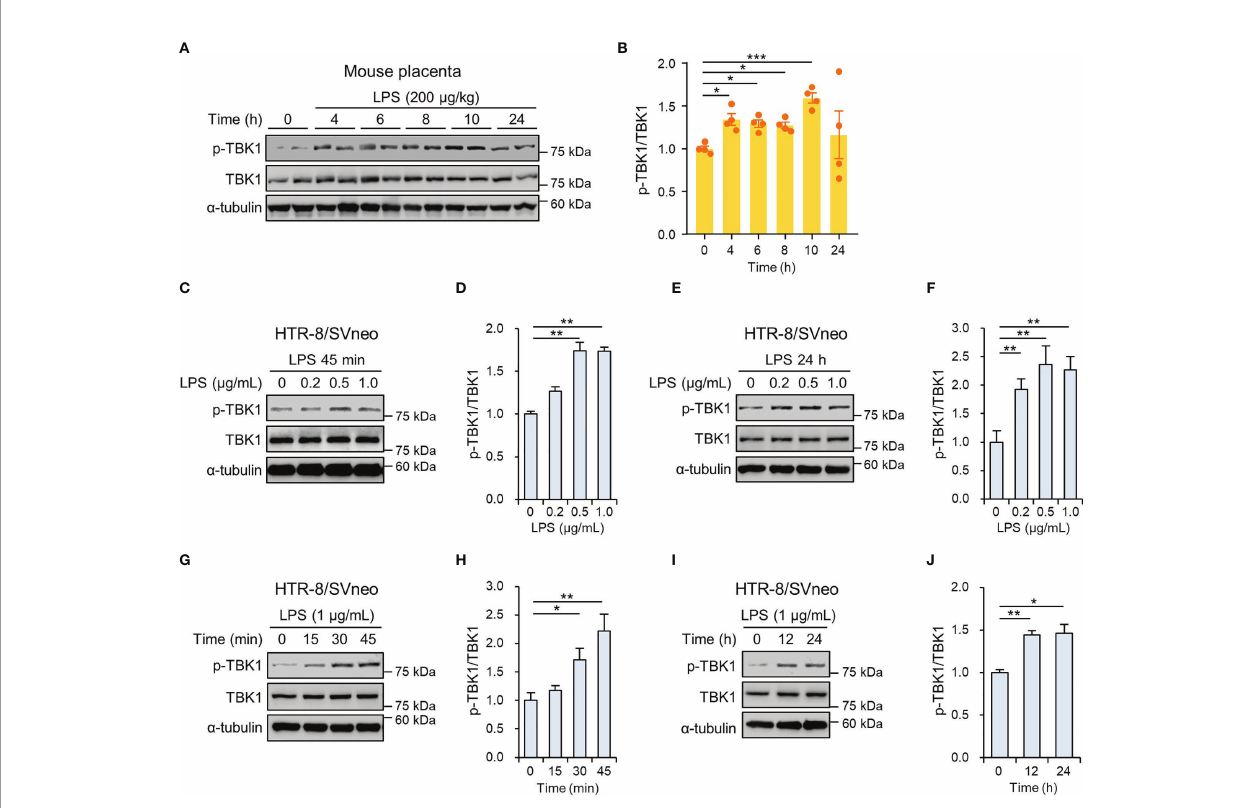
FIGURE 1 | TBK1 phosphorylation in the placenta of mice and human trophoblasts exposed to lipopolysaccharide (LPS). (A, B) Pregnant mice were injected intraperitoneally with LPS (200 m g/kg) on gestation day 17.5. After the indicated number of hours, placental tissues were collected from mice and analyzed by immunoblotting with anti-p-TBK1 and TBK1 antibodies ( n = 4 per group). (C – F) HTR-8/SVneo cells were treated with the indicated concentration of LPS for 45 min (C, D) and 24 h (E, F) . Cell lysates were analyzed by immunoblotting with anti-p-TBK1 and anti-TBK1 antibodies. (G – J) HTR-8/SVneo cells were treated with LPS (1 m g/mL) for the indicated periods. Cell lysates were analyzed by immunoblotting with anti-p-TBK1 and anti-TBK1 antibodies. a -tubulin served as a loading control. Band intensities were quanti fi ed and normalized to total protein intensities. Data are shown as means ± SEM. Results are representative of at least three independent experiments. * p < 0.05; ** p < 0.01; *** p < 0.001 (Student ’ s t